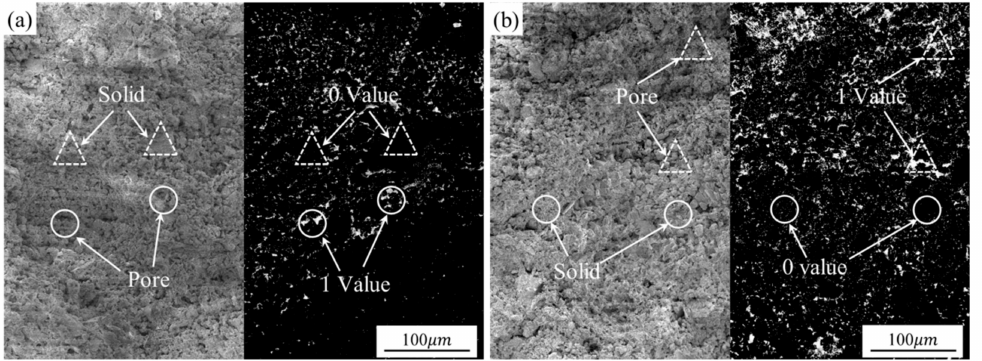
Figure 8. SEM binary image (500 × ) contrasts of ( a ) A4 and ( b )